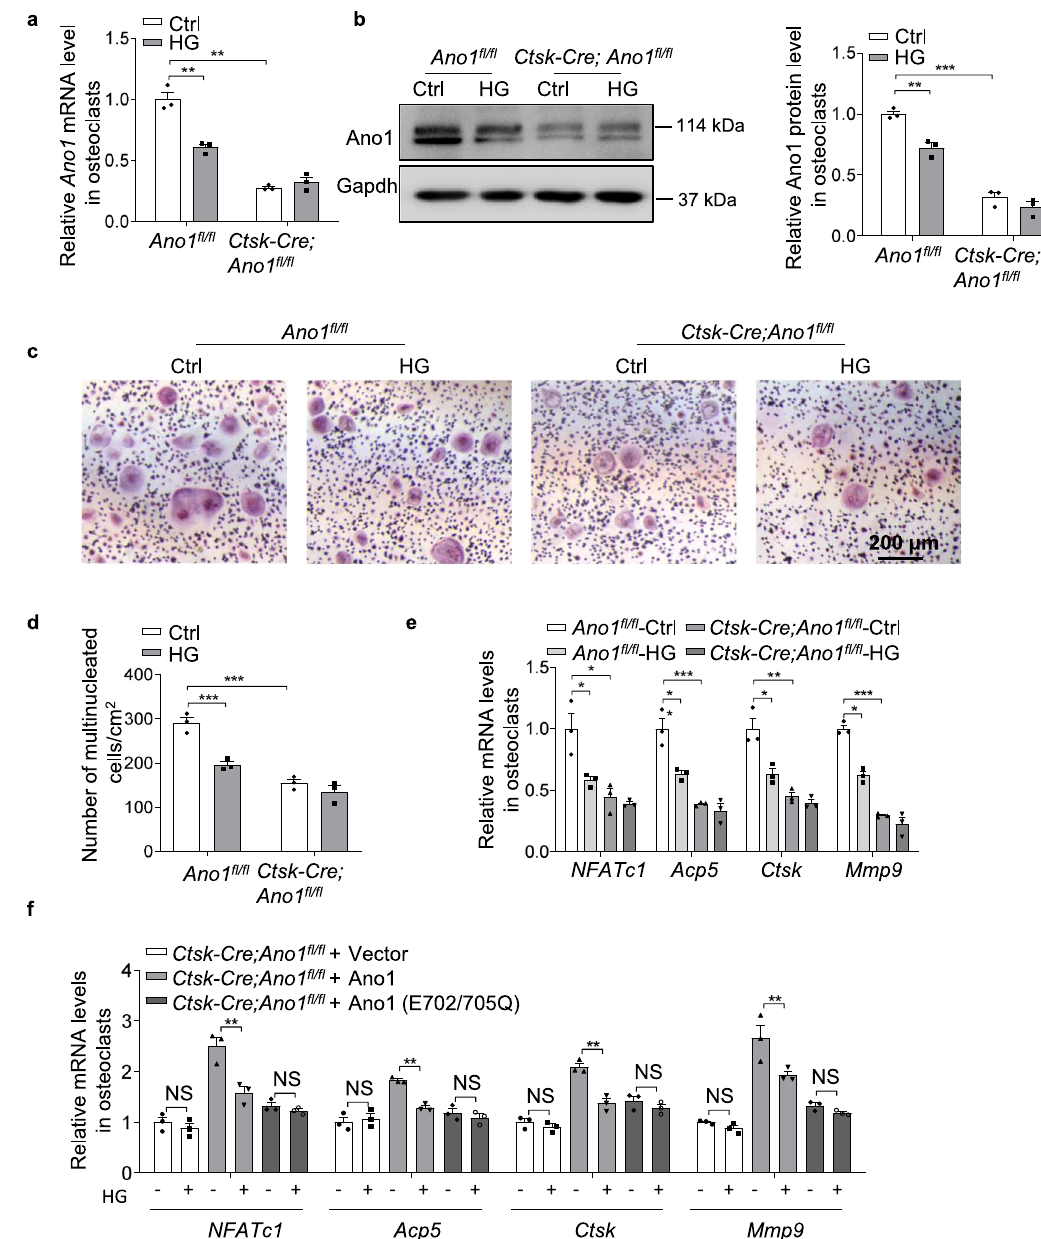
Fig. 3 Ano1 knock out blunts the inhibition of hypergravity on osteoclast activity. a QRT-PCR analysis of Ano1 mRNA level in Ano1 fl / fl and Ctsk-Cre;Ano1 fl / fl osteoclastsafter treatment withCtrl orHG(4g) for 2 days.( n = 3 independent experiments). b Western blot analysisof Ano1protein level in Ano1 fl / fl and Ctsk- Cre;Ano1 fl / fl osteoclasts after treatment with Ctrl or HG (left). The quanti fi cation of Ano1 protein level in osteoclasts (right). ( n = 3 independent experiments). c Representative images of TRAP staining in Ano1 fl / fl and Ctsk-Cre;Ano1 fl / fl osteoclasts after treatment with Ctrl or HG (4g) for 2 days. Scale bar, 200 μ m. d Quanti fi cation of the number of multinucleated cells per cm 2 . ( n = 109 – 312, from three independent experiments). e QRT-PCR analysis of NFATc1 , Acp5 , Ctsk and Mmp9 mRNA levels in Ano1 fl / fl and Ctsk-Cre;Ano1 fl / fl osteoclasts after treatment with Ctrl or HG. ( n = 3 independent experiments). f QRT-PCR analysis of NFATc1 , Acp5 , Ctsk and Mmp9 mRNA levels in osteoclasts isolated from Ctsk-Cre;Ano1 fl / fl mice. Osteoclasts were transfected with NC, WT Ano1 or mutant Ano1 (E702/705Q) and treated with or without HG for 2 days. ( n = 3 independent experiments).All data are the mean±s.e.m. Statistical analysis with more than two groups was performed with two-way analysis of variance (ANOVA) with Š ídák post-hoc test to determine group differences. *p < 0.05, **p <0.01, ***p <